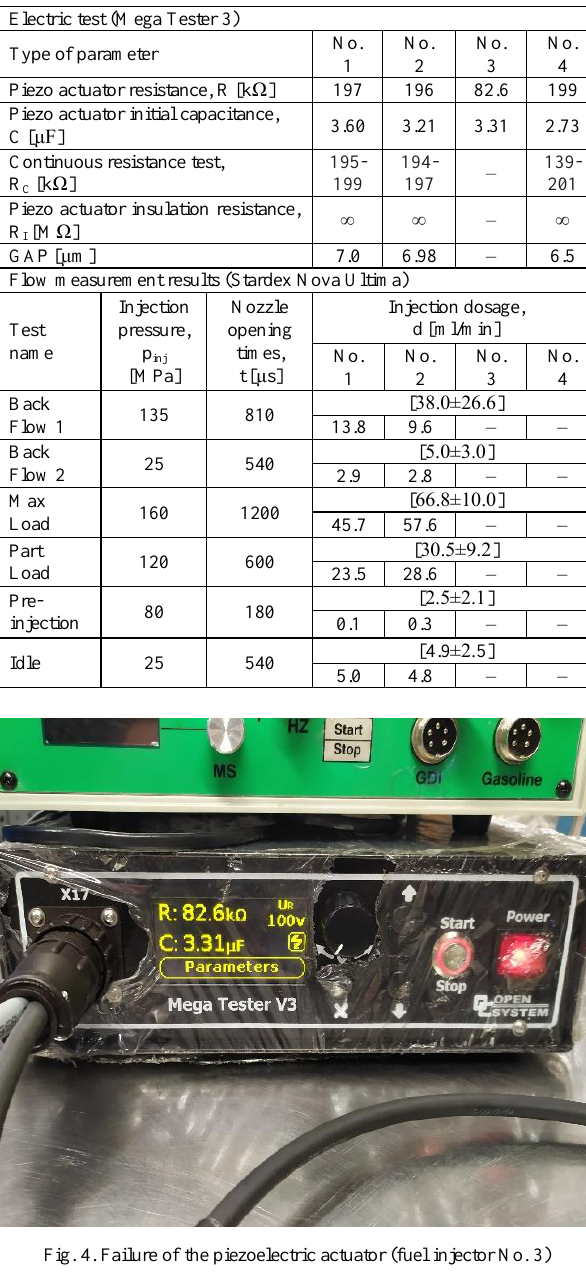
Table 1. Results of the preliminary tests